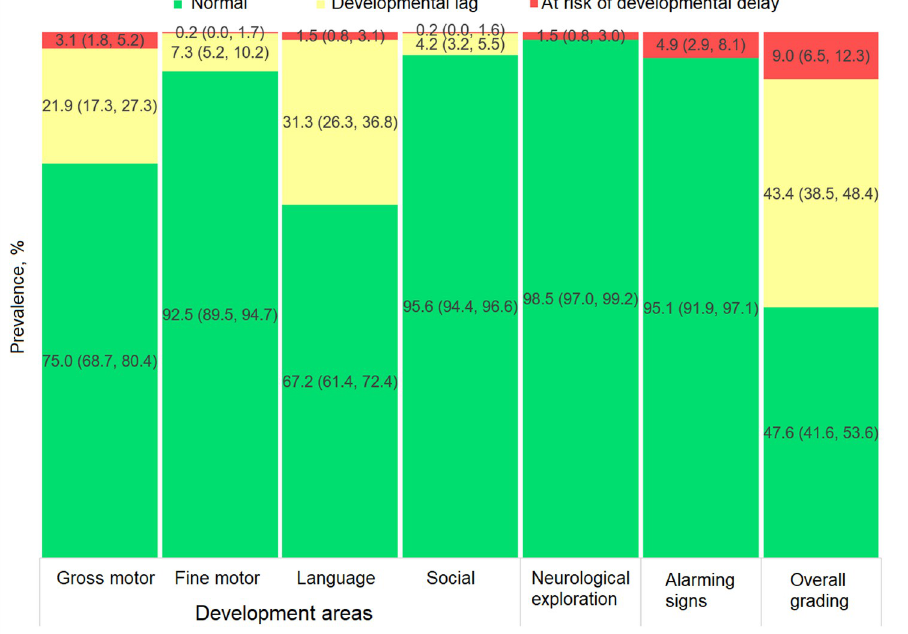
Fig 4. Prevalence of child development categories from the EDI-II test among females (n = 521). p. lower ( p = 0.001) in males (39.3%; 95% CI: 34.5%, 44.4%) compared to females (47.6%; 95% CI: 41.6%, 53.6%). The largest difference between sexes was found in the language area, with males showing a prevalence of normal development 10.6 ± 2.1 p.p. lower ( p < 0.001) than females.